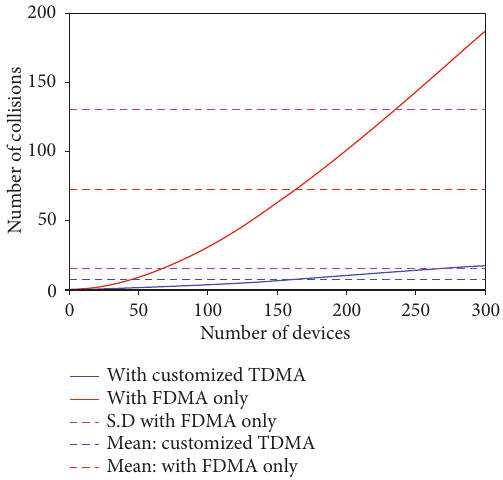
Figure 7: Number of devices vs. number of collisions.